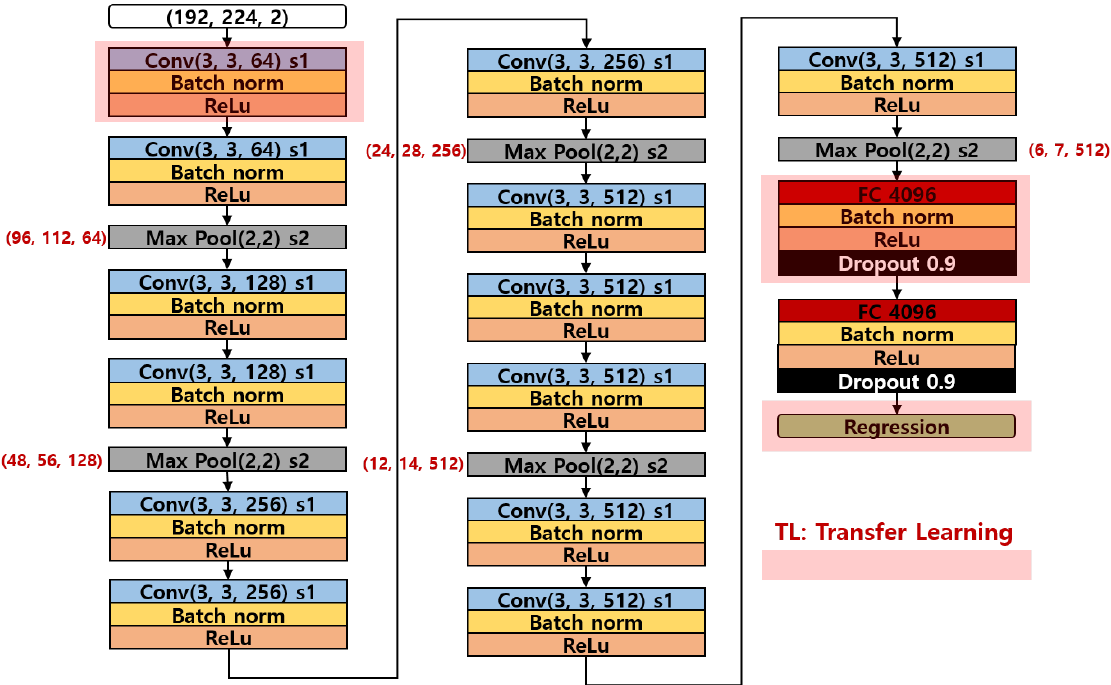
Figure 10. Network architecture of VGG16 regression model employed in the study.